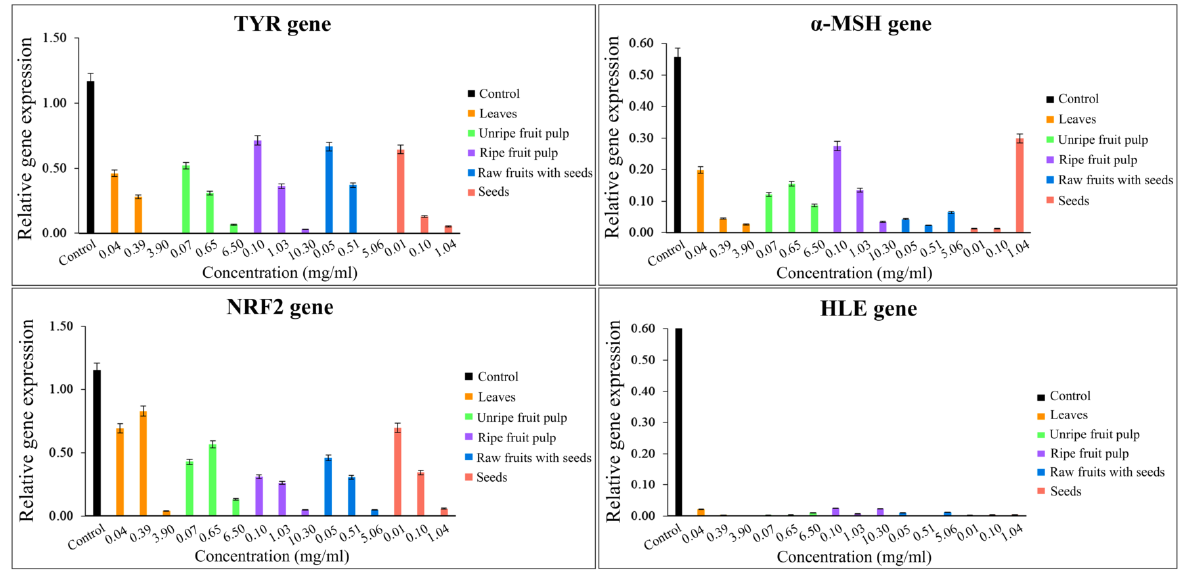
Figure 4. Graphs plotting the inhibitory gene expression value and the studied plant parts with vari- ous concentrations, showing the inhibitory effect of Morinda citrifolia (Mc) parts/extracts containing α -EG and pinoresinol.